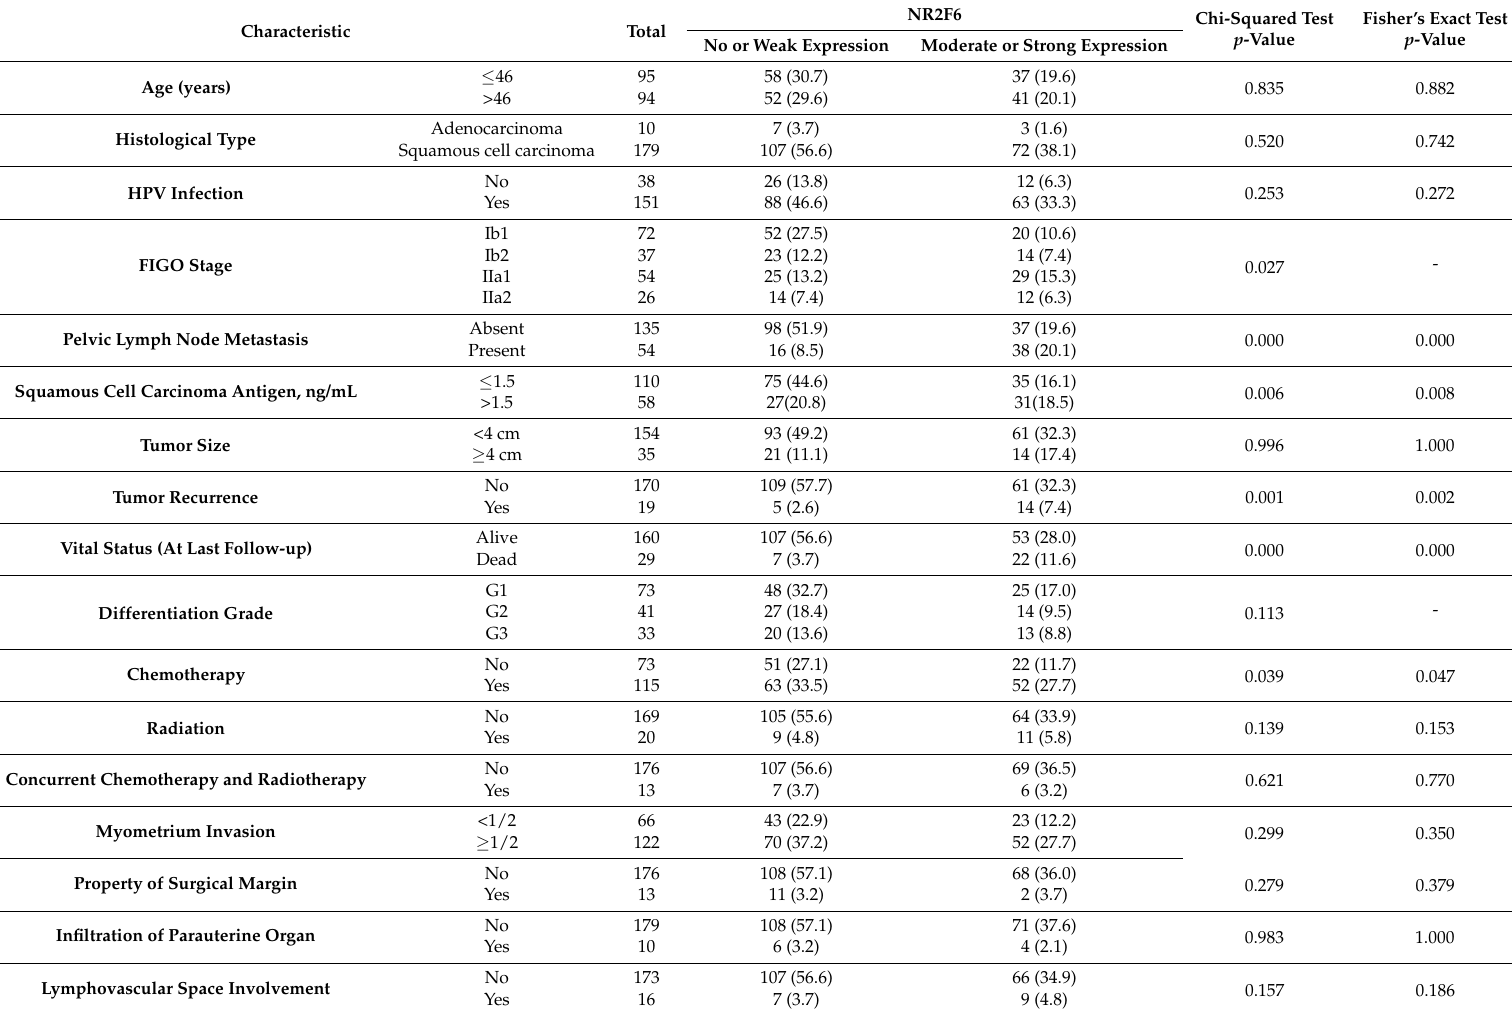
Table 2. Correlation between NR2F6 expression and the clinicopathological features of early-stage cervical